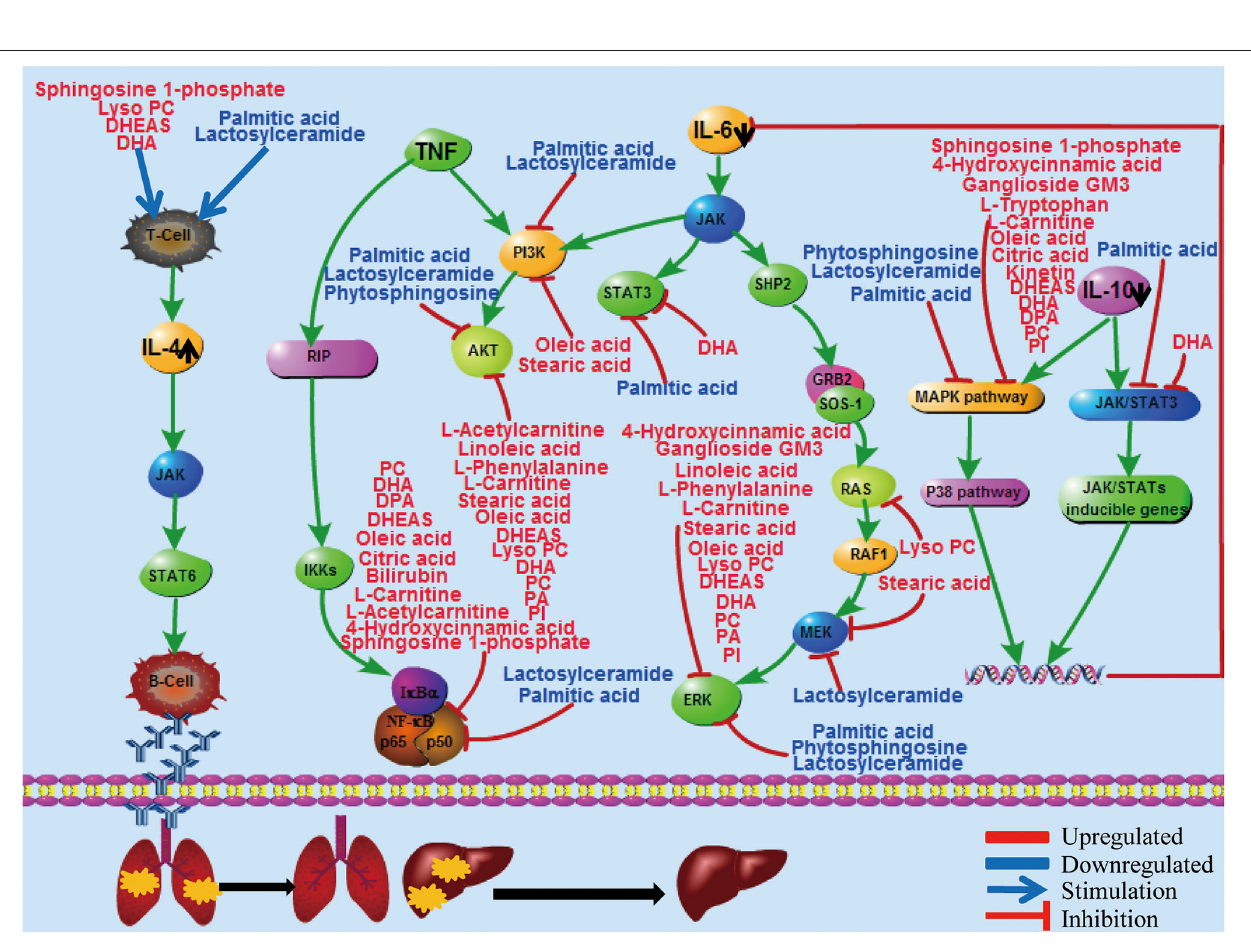
FIGURE 6 | Diagram to illustrate potential relationships among liver injury repair, inflammatory cytokine reactions, and metabolic changes in early convalescence. The red color represents upregulated metabolites and blue represents downregulated metabolites. The black arrow represents the changes of cytokines in early convalescence compared to virus replication phase. Lyso PC, lysophosphatidylcholines; PC, phosphatidylcholine; DHEAS, dehydroepiandrosterone sulfate; DHA, docosahexaenoic acid; DPA, docosapentaenoic acid; PA, phosphatidic acid; PI: